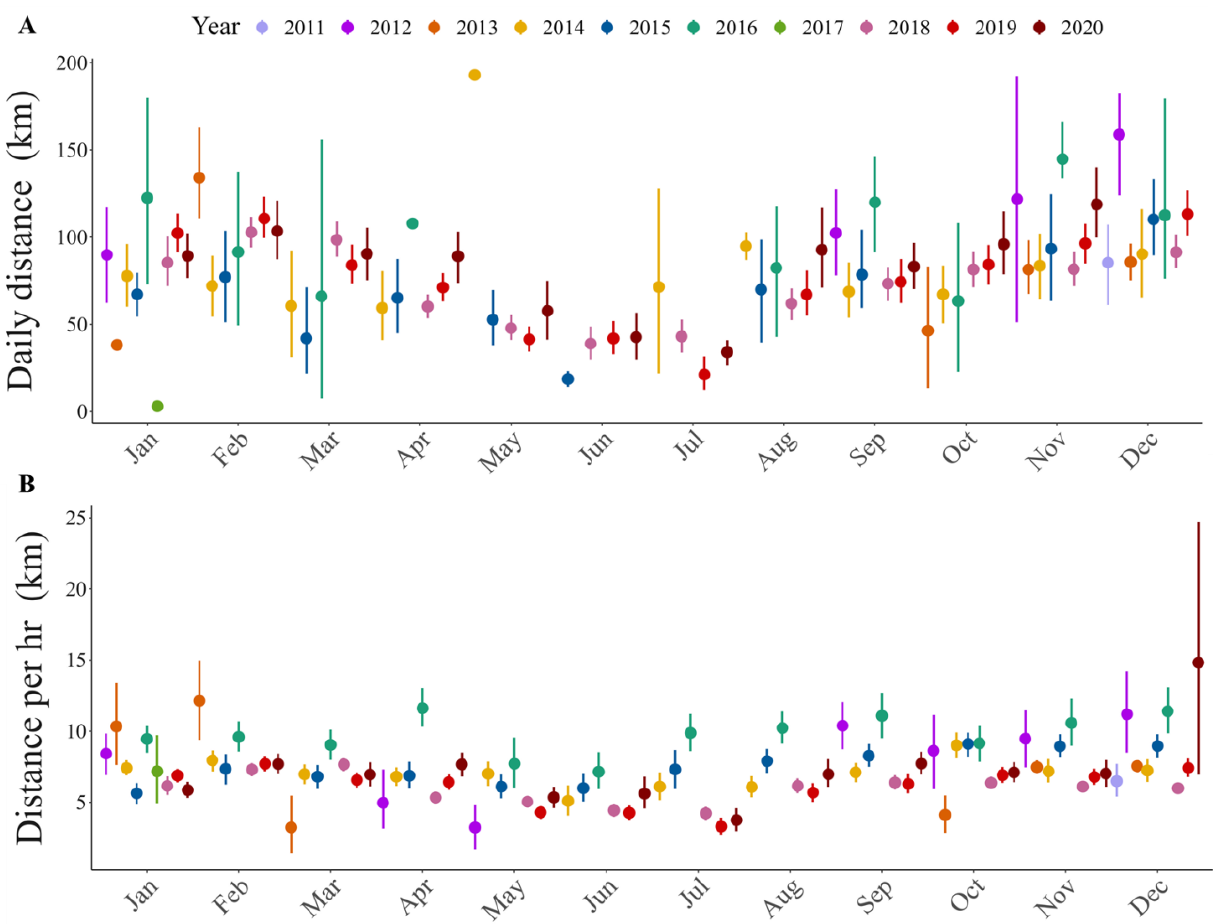
Figure 4. Trend throughout the year of flight distance: ( A ) per day, ( B ) per hour. Table 2. Linear mixed models that evaluate how the flight distances of immature Andean condor individuals can be affected by age (juvenile or sub-adult), sex and season (warm or cold) and the interactions between these variables. The asterisks show statistically significant results.